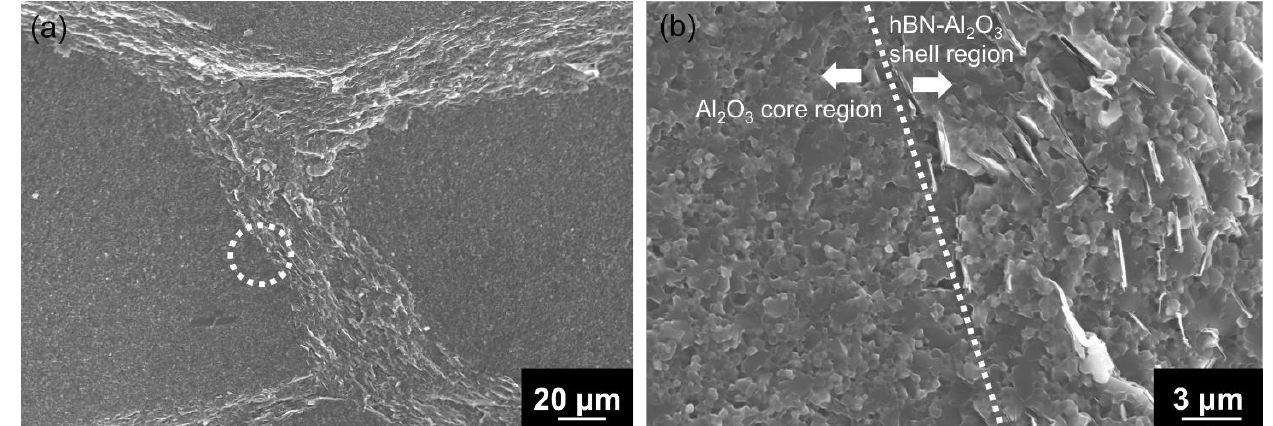
Figure 7. ( a ) The cross-sectional SEM image showing the boundary of a sintered artifact using Al 2 O 3 – hBN CS composite granules. ( b ) The high-magnification SEM image taken at the grain boundary marked in ( a ) with a circle (dotted line), indicating a distinguished interface (straight dotted line) between the Al 2 O 3 core region (left) and Al 2 O 3 – hBN shell region (right).